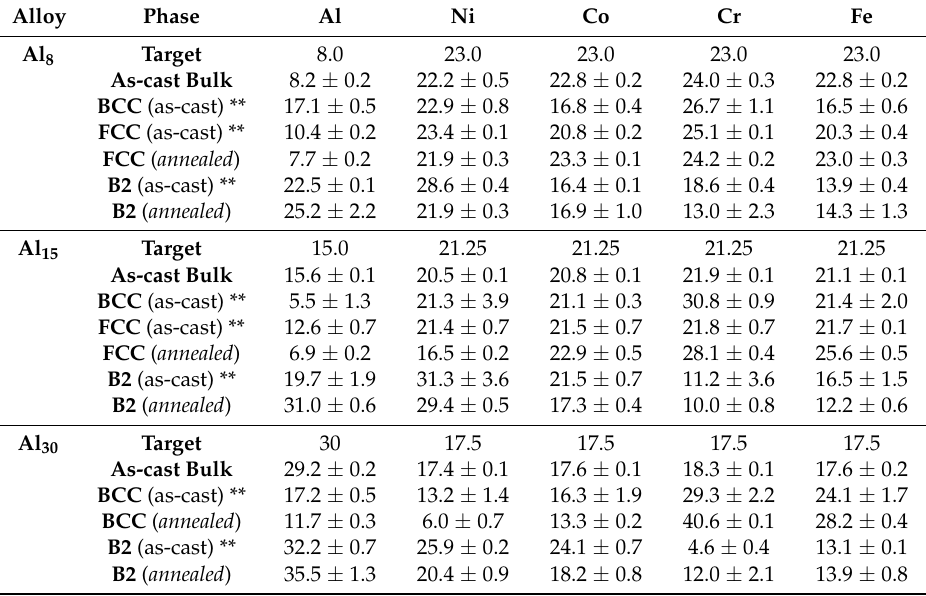
Table 1. Chemistries of the as-cast HEAs in at % (SEM-EDS). The respective phase chemistries for each as-cast HEA and after annealing for 120 h/1050 ◦ C are also shown. ** As-cast chemistries taken from [7,15].